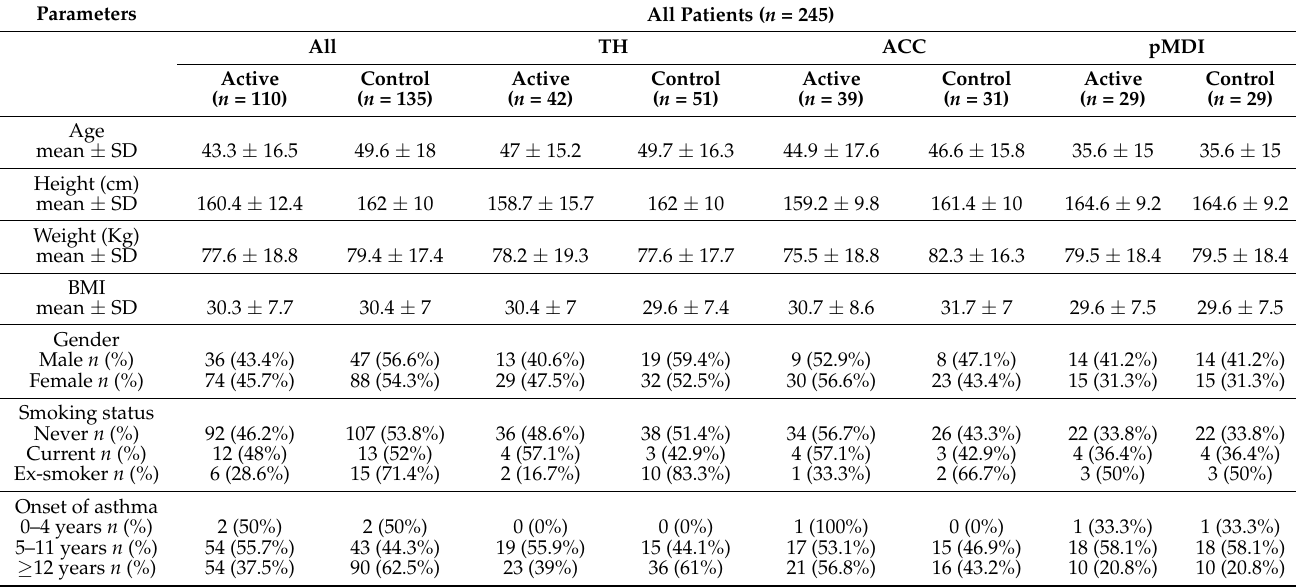
Figure 1. Consort diagram showing participants’ recruitment and retention during the study period. Table 1. Demographic information for the different inhaler groups participants ( n =